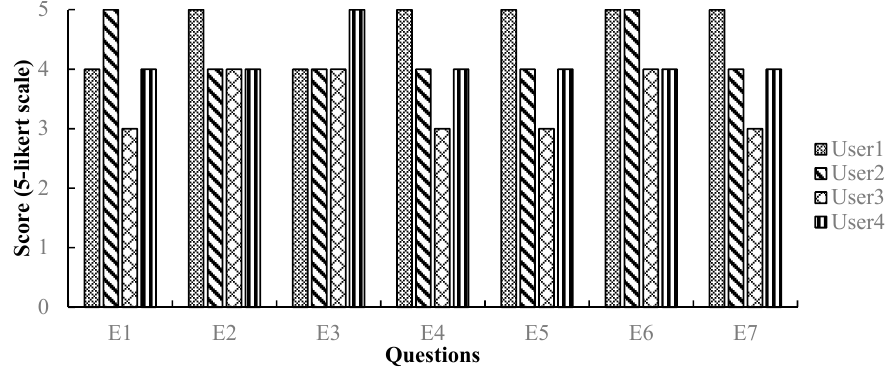
Figure 20. Evaluation results.